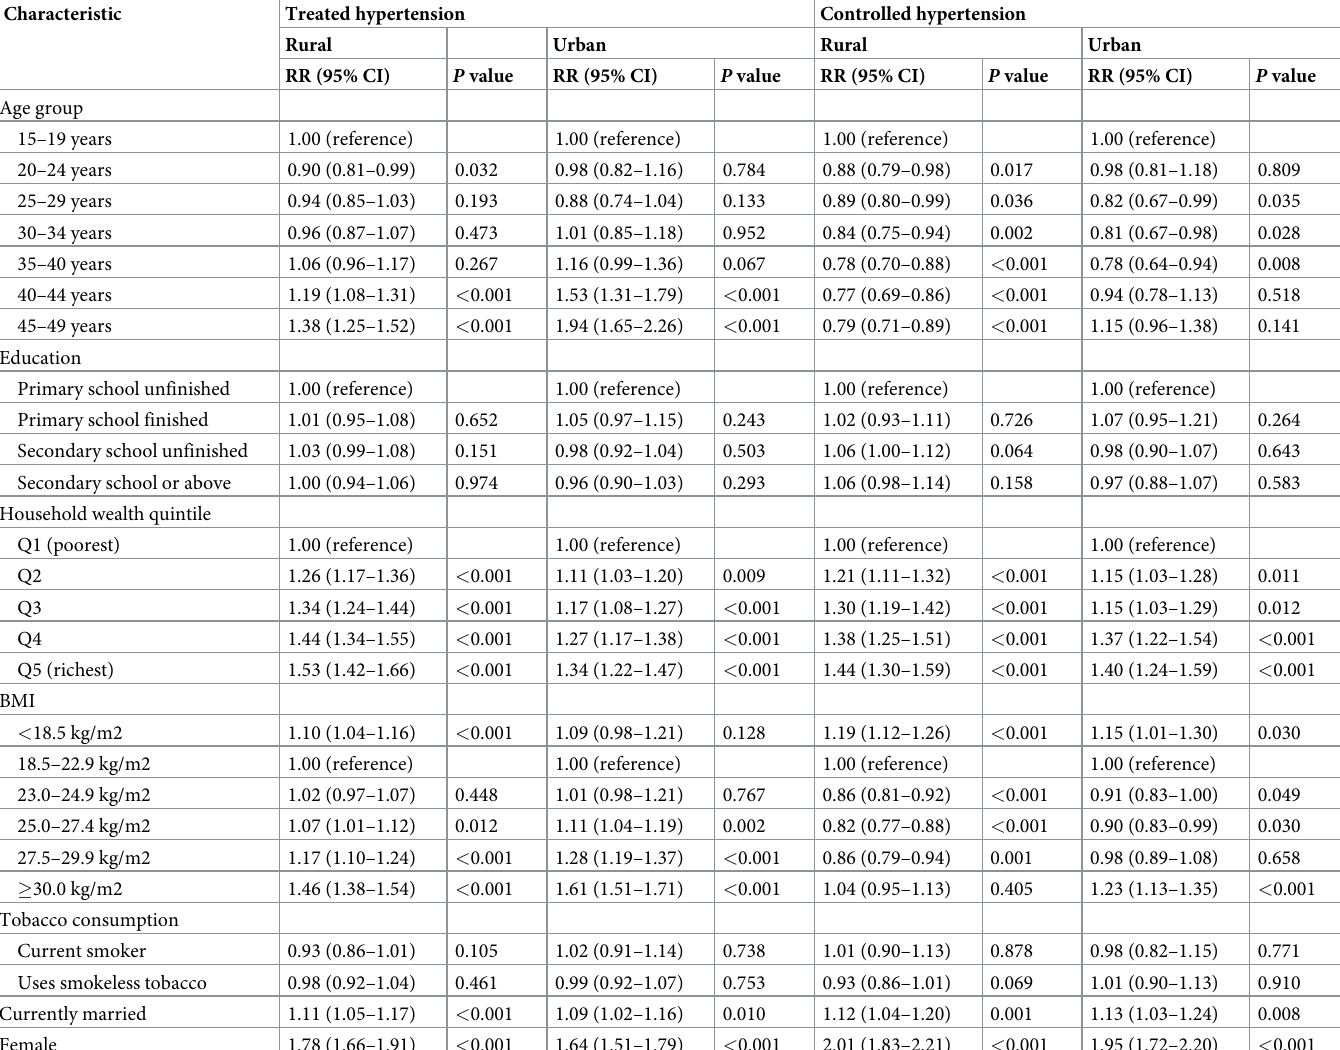
Table 2. Predictors of having treated and controlled hypertension among adults with